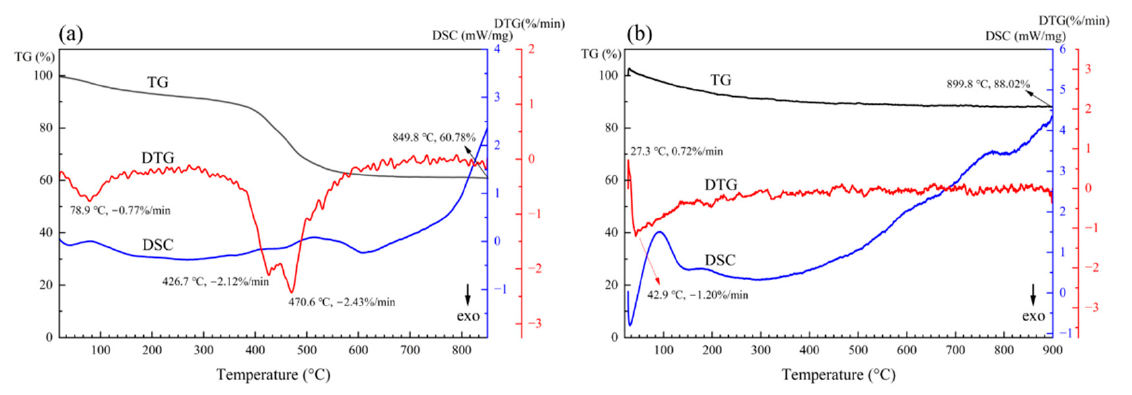
Figure 1. The TGA results of the coatings: ( a ) chromium-free semi-inorganic coating and ( b ) chromium-free inorganic coating.